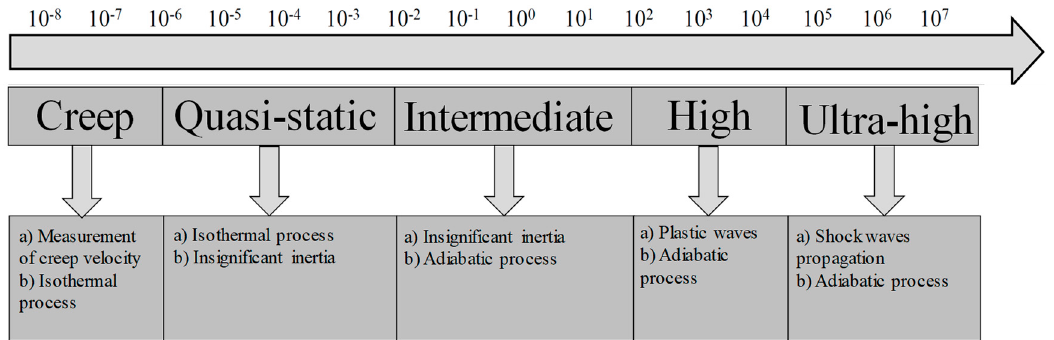
Table 1. Test methods for different regimes of strain rate [14] .